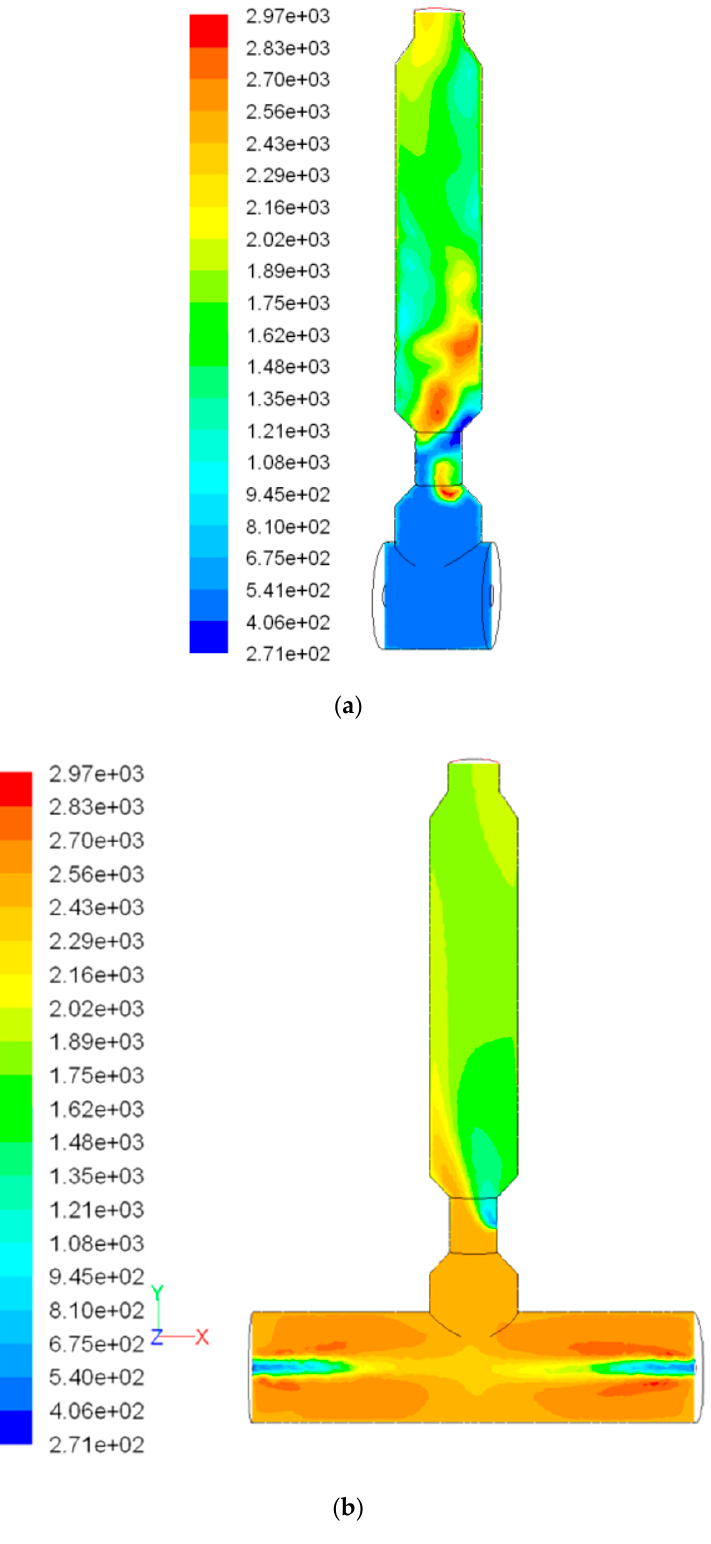
Figure 3. Comparison of mid-plane temperature distributions for ( a ) E-STR model and ( b ) E-Gas model.